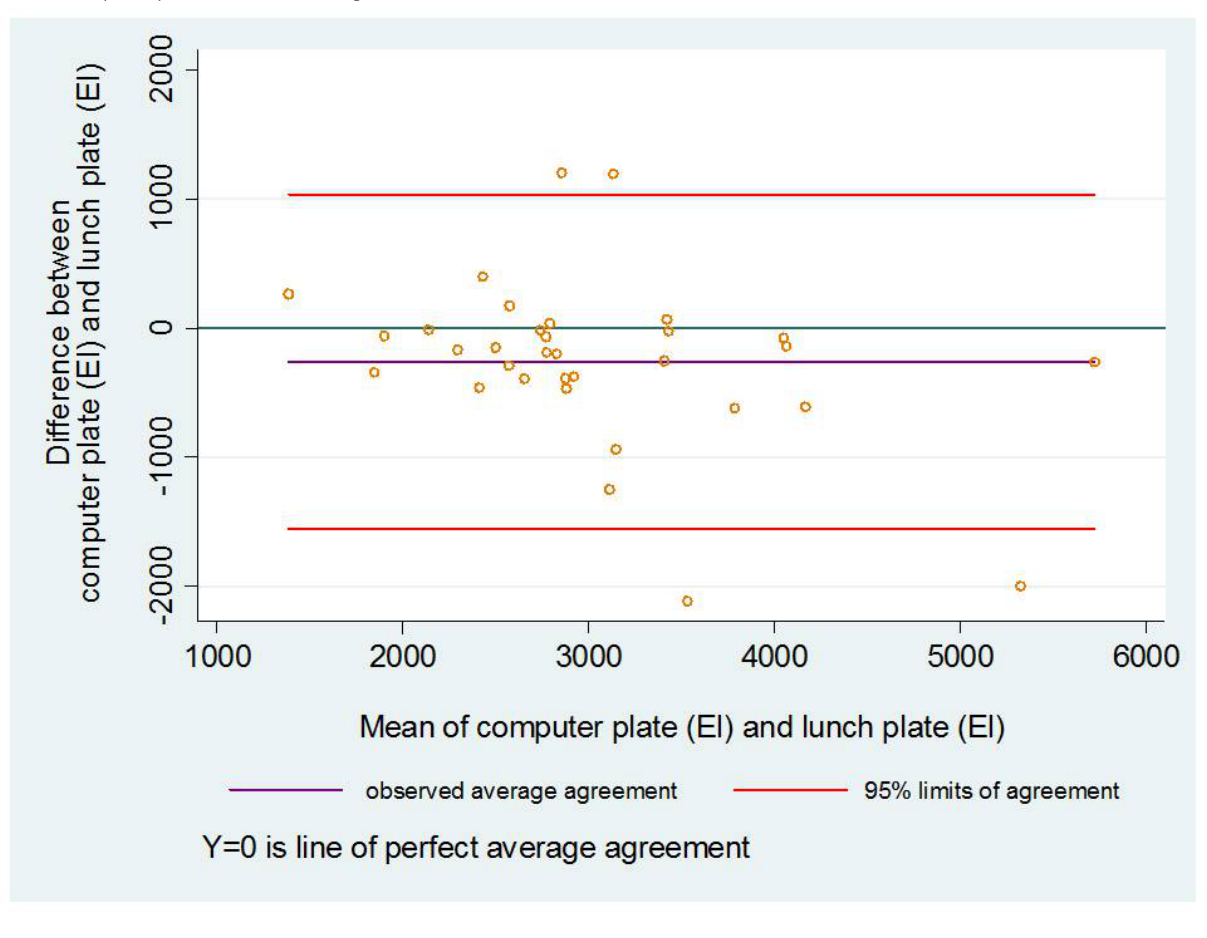
Figure 4. Bland-Altman plot of the differences between total energy intake (EI, kJ) of the computer plate and the real lunch plate against the mean